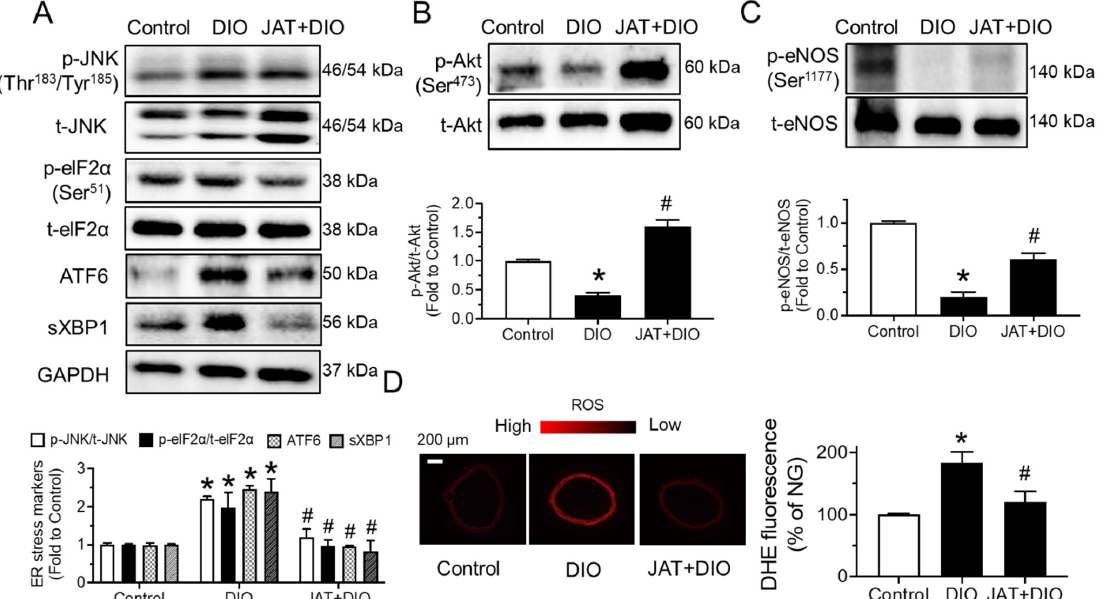
Figure 9. Chronic jatrorrhizine treatment attenuates endoplasmic reticulum stress and increases Akt/eNOS pathway in DIO mice. ( A – C ) The expressions of ER stress markers (JNK, eIF2 α , cleaved ATF6 and spliced XBP1) and Akt/eNOS in aortas from DIO mice. ( D ) Changes in ROS as measured by dihydroethidium (DHE) staining. Data are mean ± SEM from 5–6 mice for each group. * p < 0.05 vs. Control; # p < 0.05 vs. DIO.